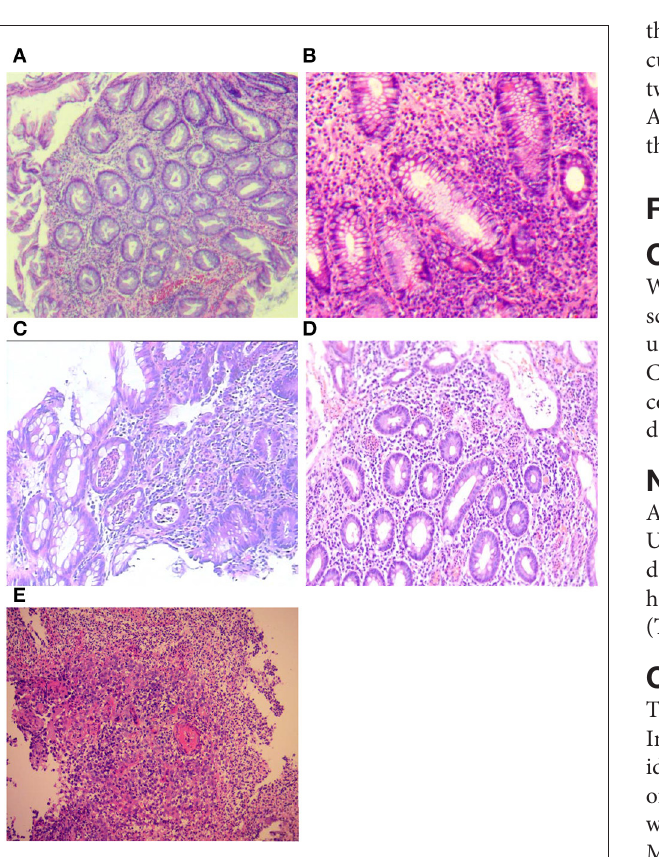
of variance (ANOVA) was used for the parametric values. For correlations, Spearman’s rank correlation coefficient was